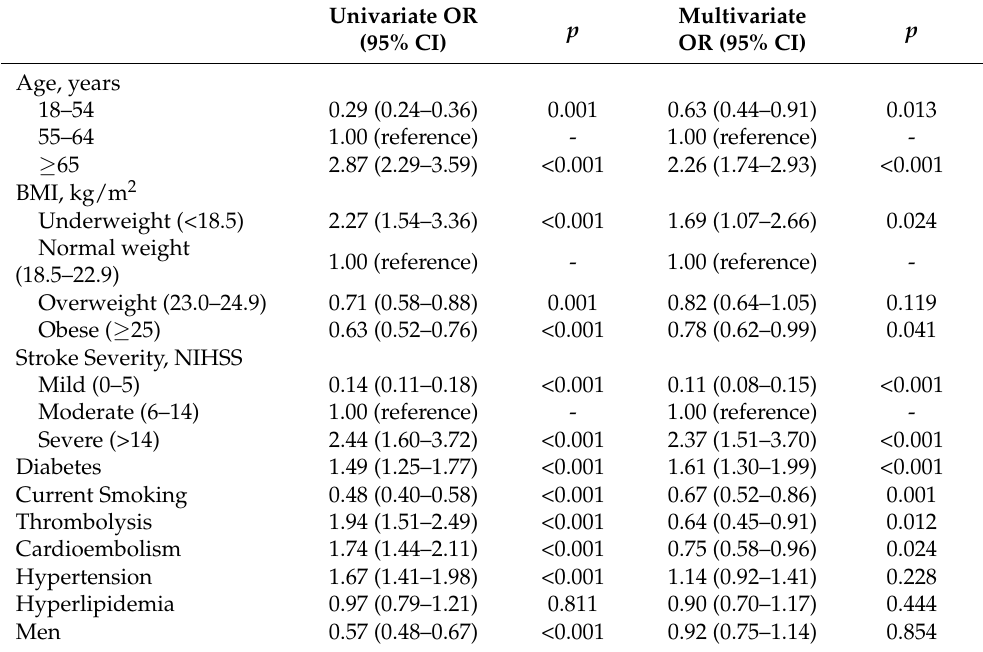
Table 5. Results of binary logistic regression analysis for predictors of poor functional outcome at 3 months in patients with acute ischemic stroke.